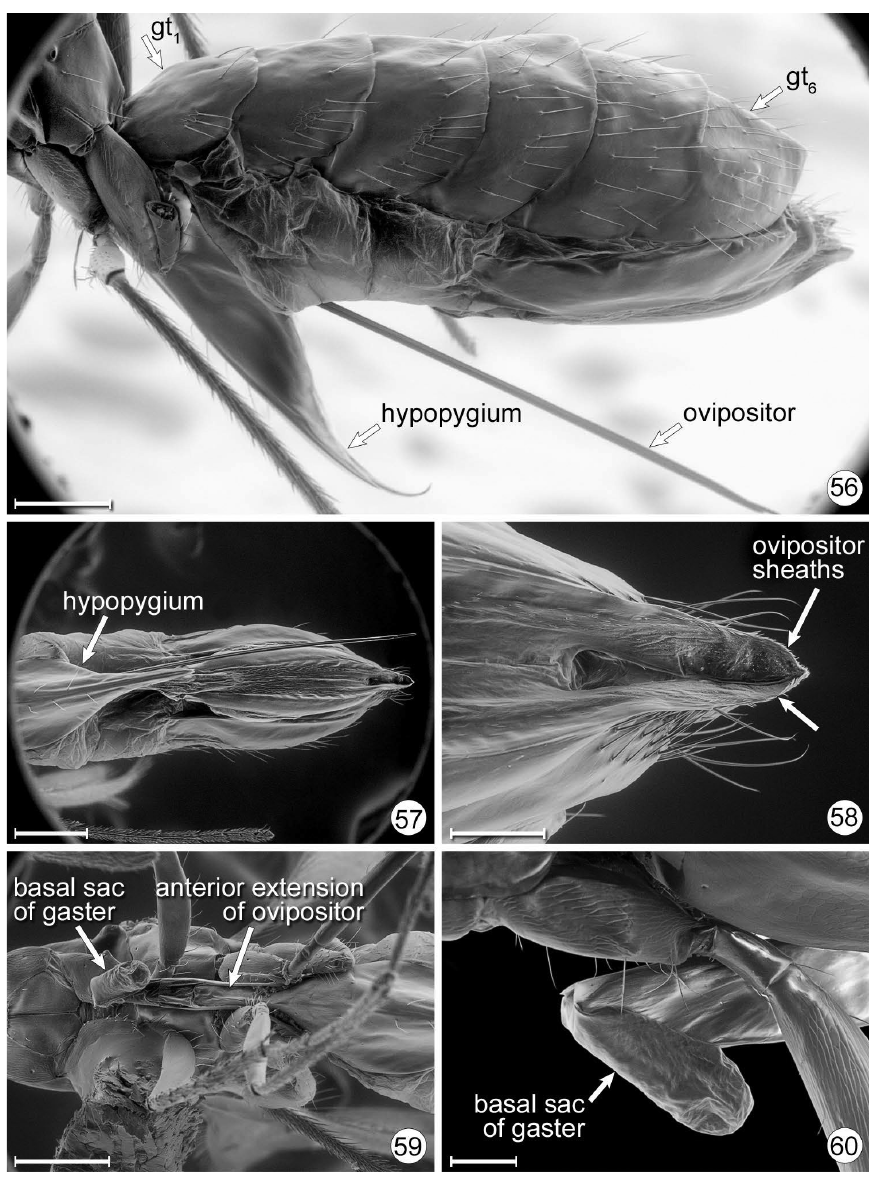
Figures 56–60. Neotriadomerus spp. 56 N . sp. metasoma, lateral 57 N . sp. metasoma, ventral 58 N . sp. apex of metasoma, ventral 59 N . sp. mesosoma and ovipositor sac, ventral 60 N . sp. apex of ovipositor sac, lateral. Scale bar for 56, 57, 59 = 200 μm; 58, 60 = 50 μm. gt –gt with even more in 2 or more irregular rows, those around spiracle often shorter; 4 6 gt with about 10 setae in one row. Hypopygium with about 4 ventral setae. Cerci with 7 4 fairly long curved